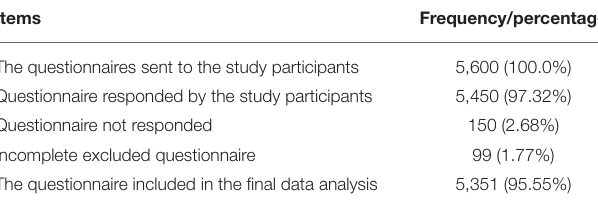
TABLE 1 | Data quality check